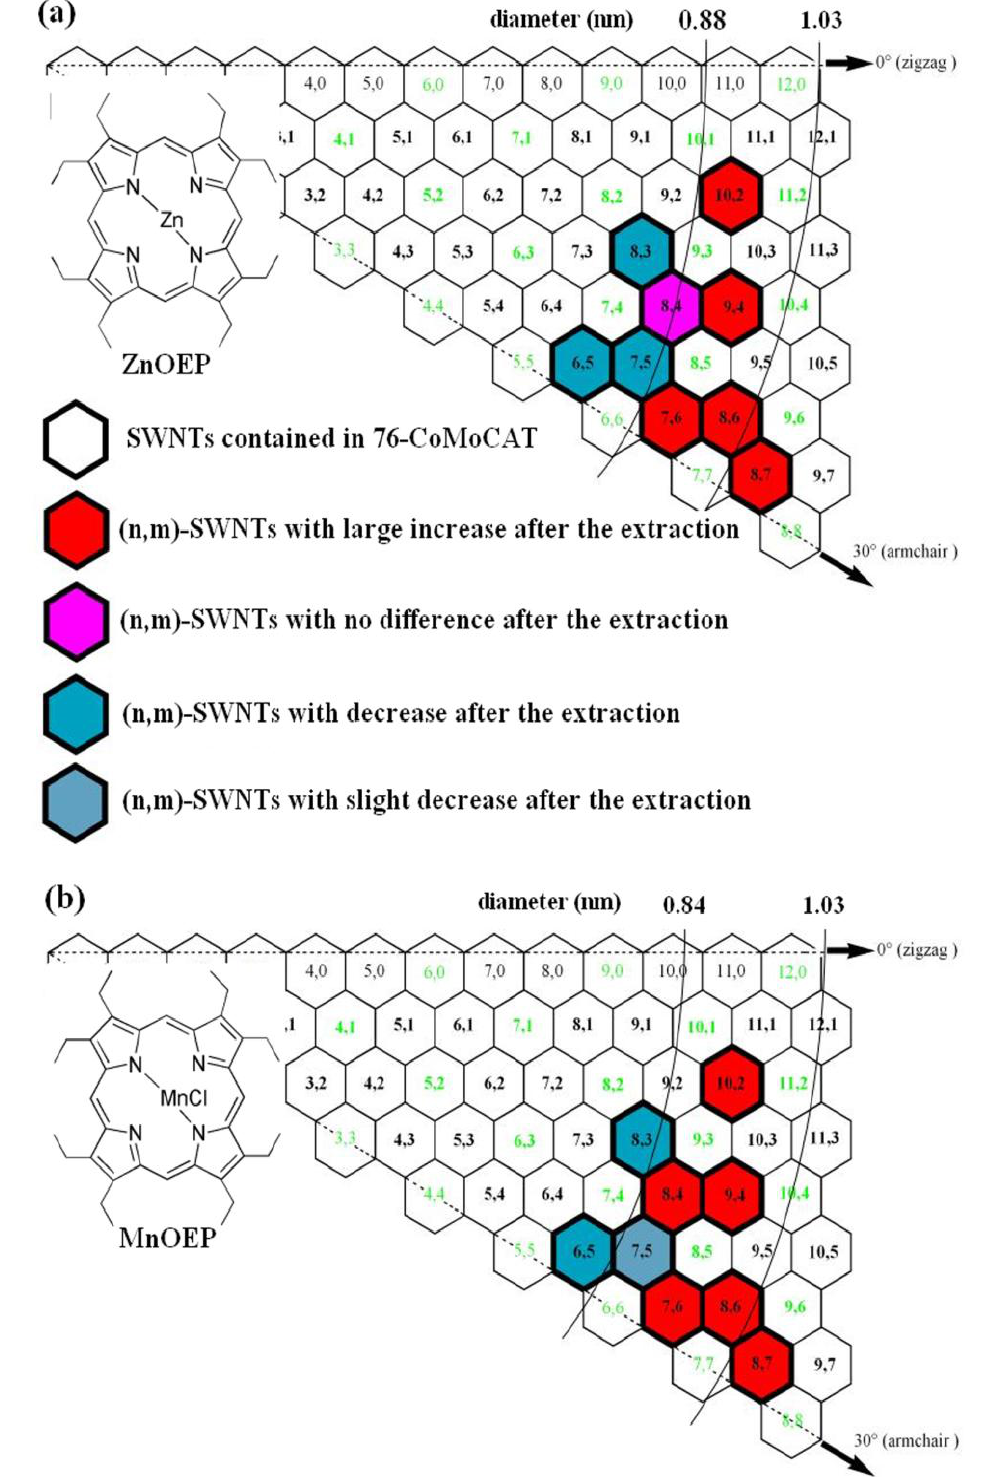
Figure 7. Summary of enrichment in ( n , m ) abundance in the extraction of 76-CoMoCAT with ZnOEP ( a ); and MnOEP ( b